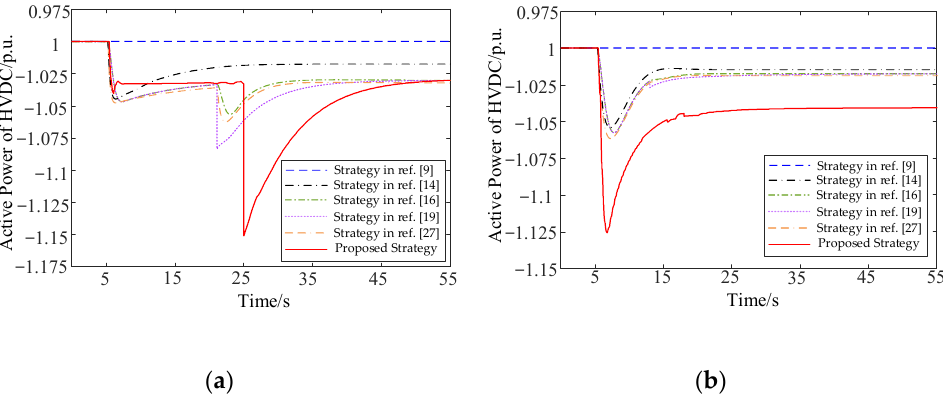
Figure 22. Active power of HVDC. ( a ) Active power of HVDC based on the operating conditions of Case 1 and ( b ) active power of HVDC based on the operating conditions of Case 2. Table 8. Control strategies of a HVDC-WF system for frequency response. Strategies Strategy in ref. [9]